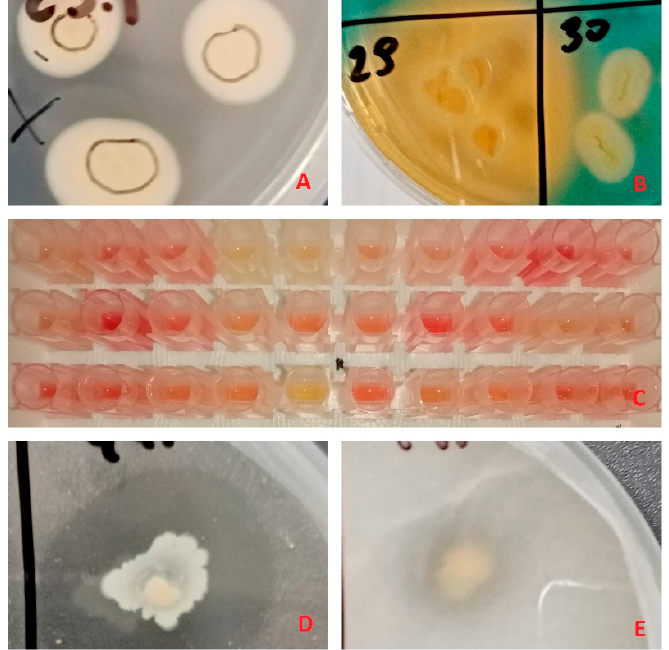
Figure 1. Examples of plant growth promoting trait tests: ( A ) bacterial growth on Jensen’s medium, indicating putative nitrogen fixation capabilities, ( B ) orange zones on Chromeazul S (CAS) medium, indicating siderophore production, ( C ) supernatant color change to red after addition of Salkowski reagent, indicating indole-3-acetic acid (IAA) production, ( D and E ) clear zones in insoluble phosphate enriched media, indicating phosphate mineralization and solubilization respectively.